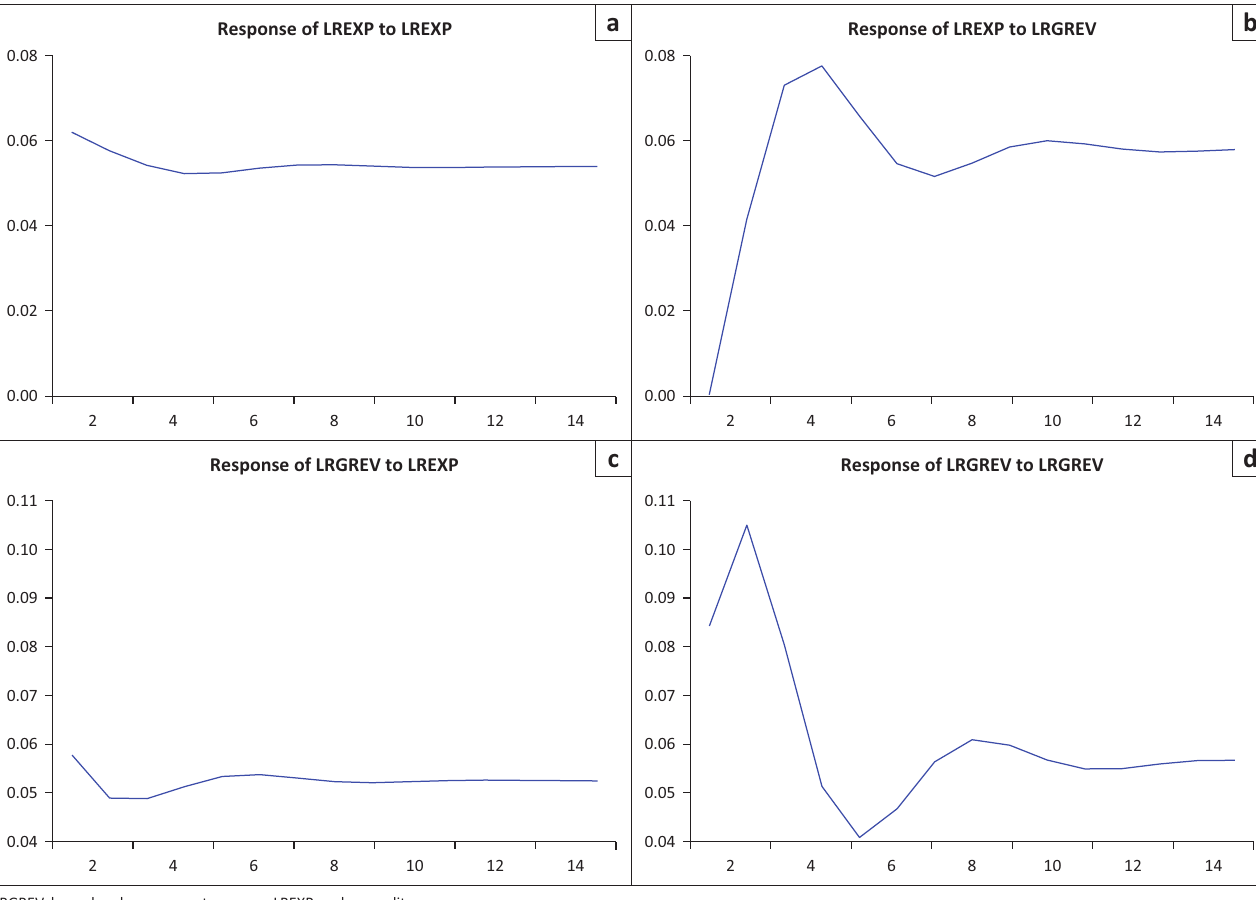
LRGREV, logged real government revenue; LREXP, real expenditure. FIGURE 7: Generalised impulse responses for one standard deviation (SD) shock for Vector error correction model equations: (a) shows the response of real government expenditure following a shock from itself; (b) shows the response of real government expenditure following a positive shock in real government revenues; (c) shows the response of real government revenue following a positive shock in government expenditure; and (d) shows the response of real government revenue following a shock from